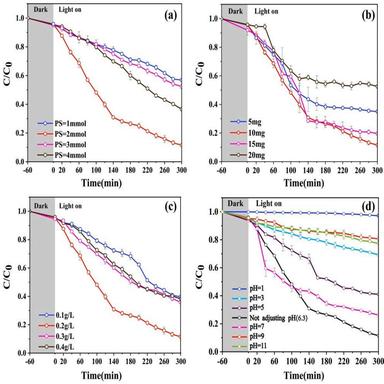
Effects of operating parameters on the degradation of sulfameter: (a) persulfate (PS) dosage, (b) sulfameter concentration, (c) Fe-UiO-66 dosage, and (d) initial pH.